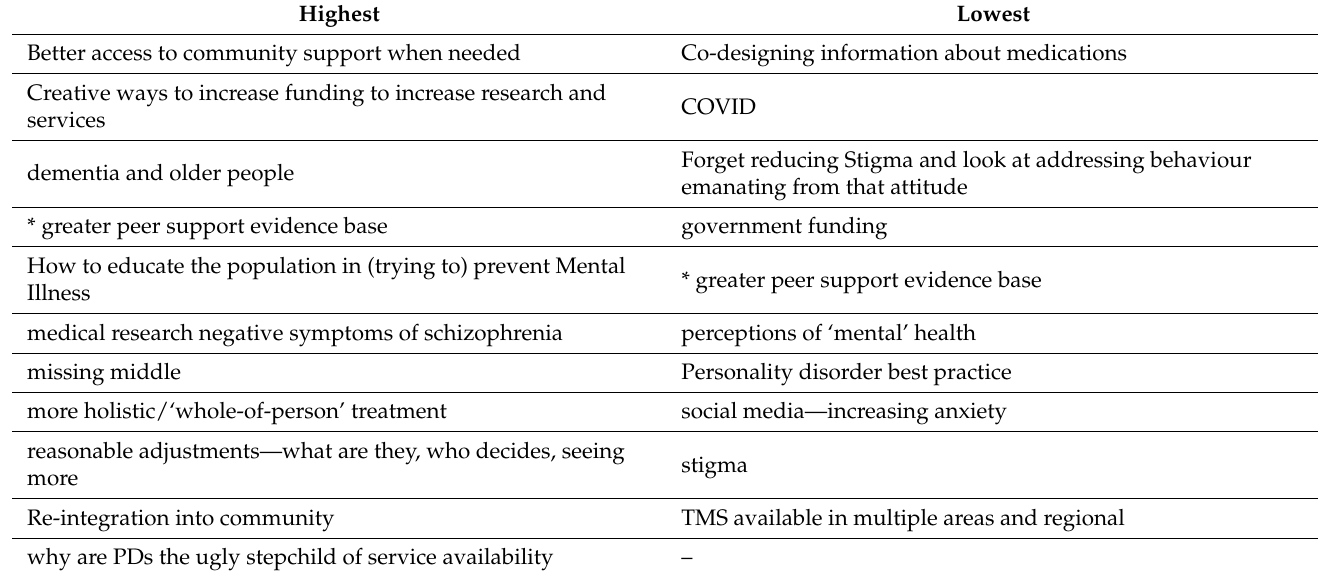
Table 2. Highest and lowest priorities as voted by participants ( n =